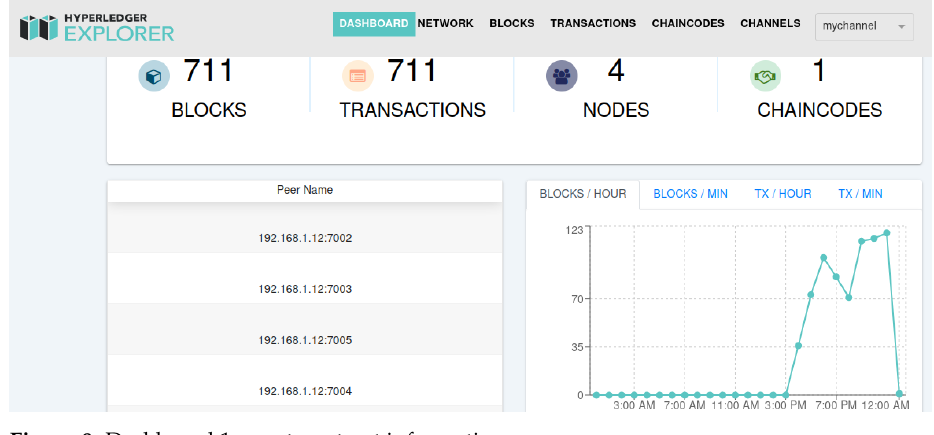
Figure 8. Dashboard 1 smart-contract information.